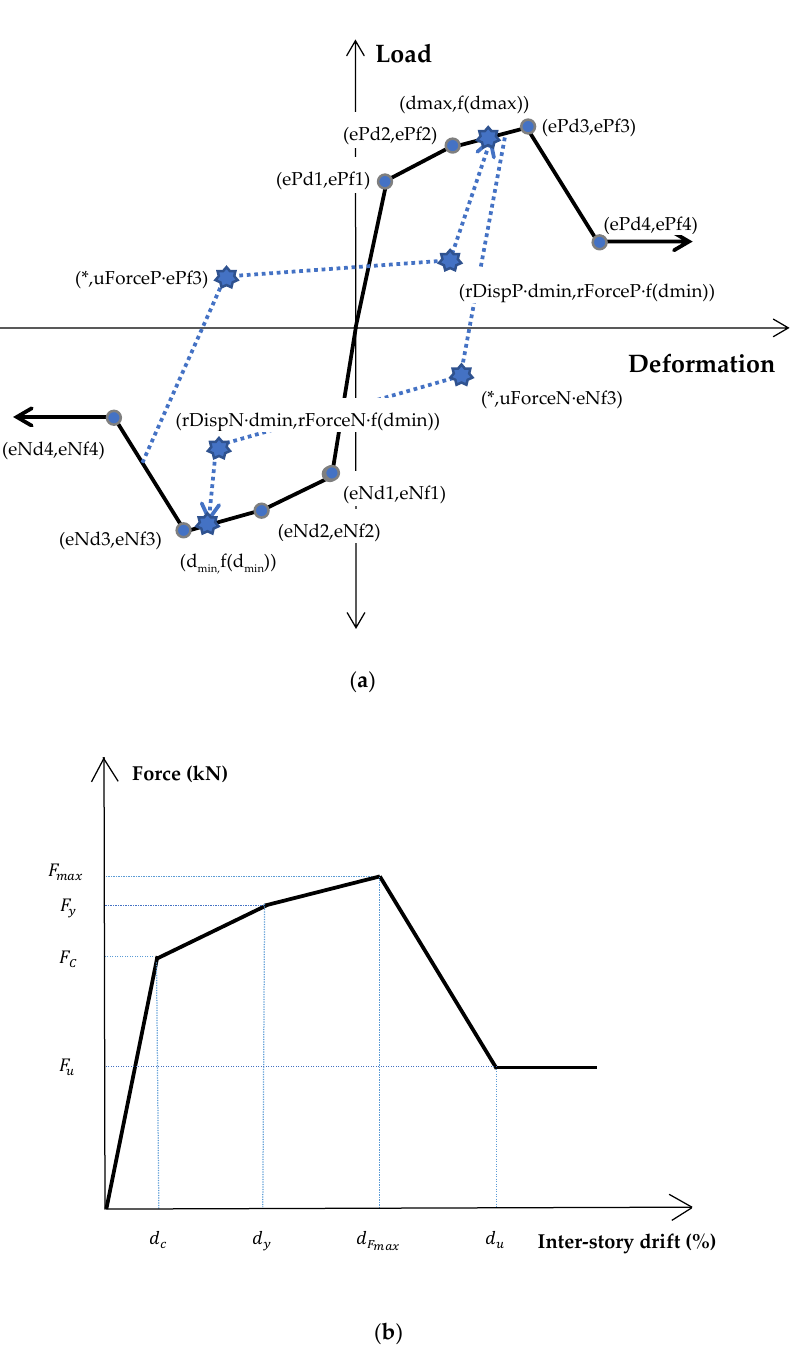
Figure 4. Pingching 4 constitutive model; ( a ) hysteretic behavior; ( b ) skeleton curve. The determination of the mechanical performance of the infill wall needs to first determine the skeleton curve. The tension and compression parts of the skeleton curve used in this paper are the same, and the load and displacement values for the four characteristic points are shown is Figure 4b and are determined as follows [40,41]: * The ratio of the cracking strength F c to the peak strength F max is taken as 0.55, and the cracking inter-story drift ratio d c is between the values 0.075% and 0.12%. * The yielding strength F y and inter-story drift ratio d y are the intermediate values between the coordinate values of the cracking and peak points, that is, F y = ( F max + F c ) /2, and d y = ( d F c max + 𝑑 )/2 .